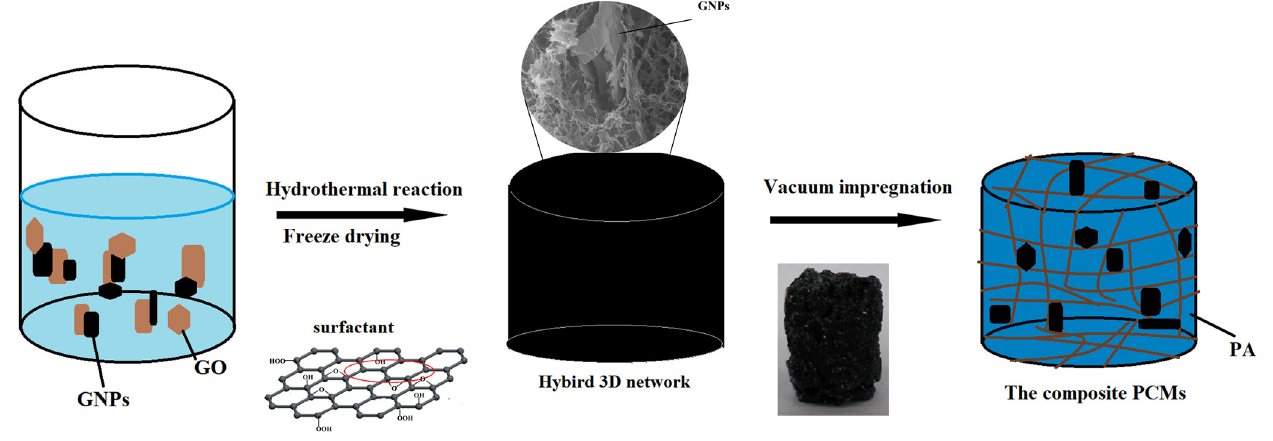
Figure 1. Schematic illustration of the preparation procedure of PA/HGA. Table 1. The HGA, GNPs, and PA contents in PA/HGA.